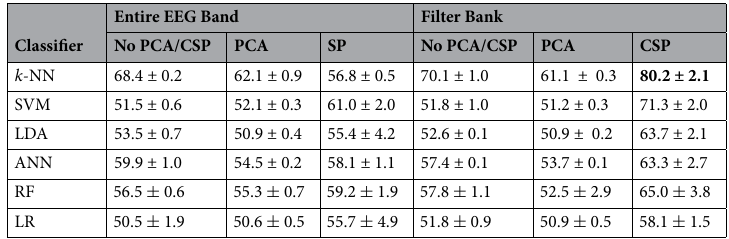
Table 5. Accuracy (mean and standard deviation) without considering a priori knowledge i.e. Asymmetry - Cross-subject. The best performance value is highlighted in bold.